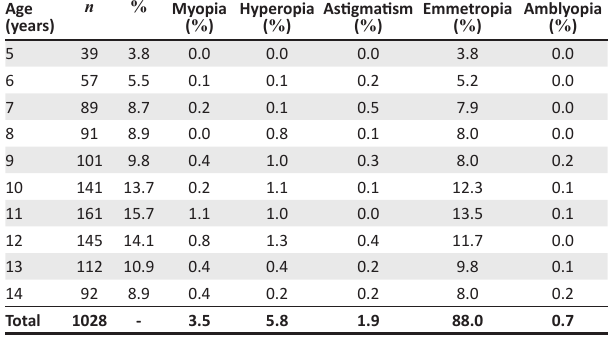
TABLE 2: Distribution of refractive errors by